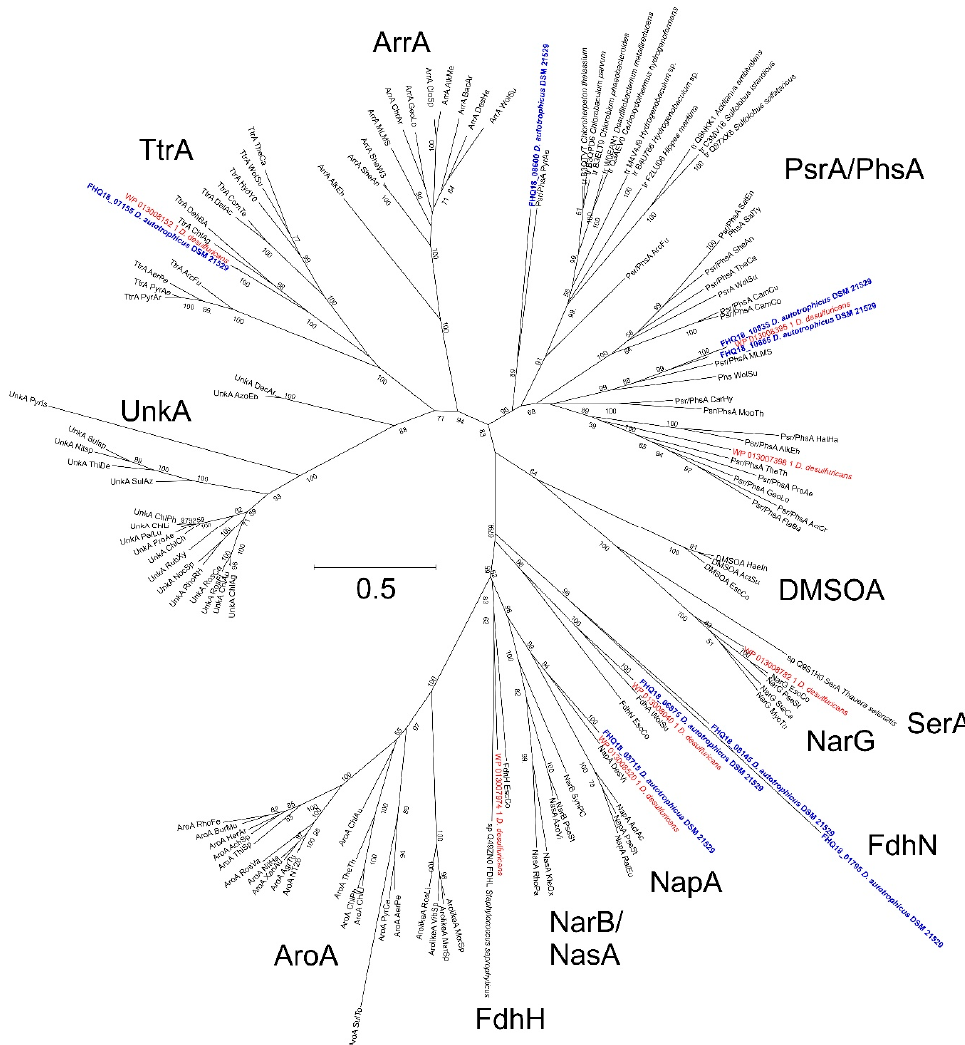
Figure 7. A maximum likelihood phylogenetic tree showing the position of D. autotrophicus (bold blue) and D. desulfuricans (red) molybdopterin oxidoreductase catalytic subunits A among the reference sequences [23], representing various molybdopterin protein families. The tree with the highest log likelihood is shown. The percentages of trees in which the associated taxa clustered together (bootstrap values, 1000 replicates) are shown next to the branches. This tree was inferred in MEGA6. The catalytic subunit clusters shown are: PsrA / PhsA, polysulfide reductase / thiosulfate reductases; AroA, arsenite oxidases; Arr, arsenate reductases; DMSOA, dimethylsulfoxide reductases; FdhN and FdnH, formate dehydrogenases; NapA, periplasmic nitrate reductases; NarG, membrane-bound nitrate reductases; NarB / NasA, assimilatory nitrate reductases (Nas); TtrA, tetrathionate reductases; SerA, selenate reductase; and UnkA, unknown reductases. Branch lengths (see the scale) correspond to the number of substitutions per site with corrections associated with the evolutionary